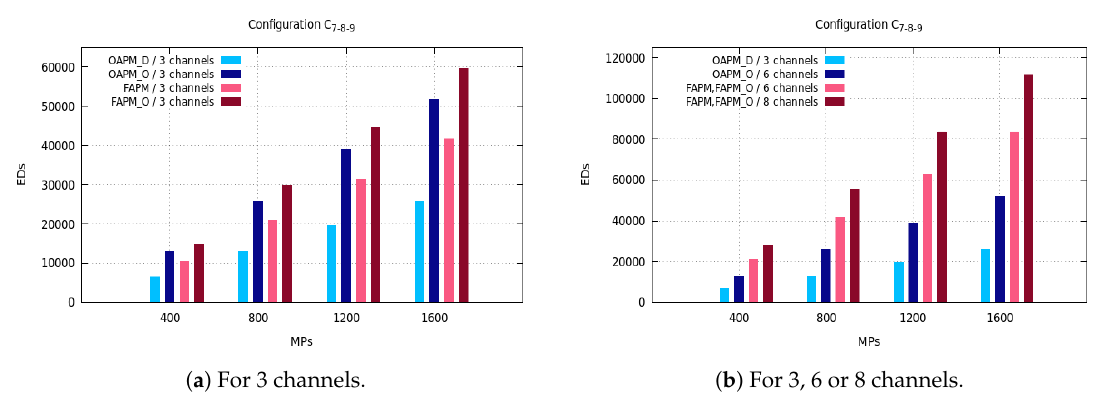
Figure 8. Number of EDs supported by by OAPM_D, OAPM_O, FAPM and FAPM_O in C 33,33,33,0,0,0